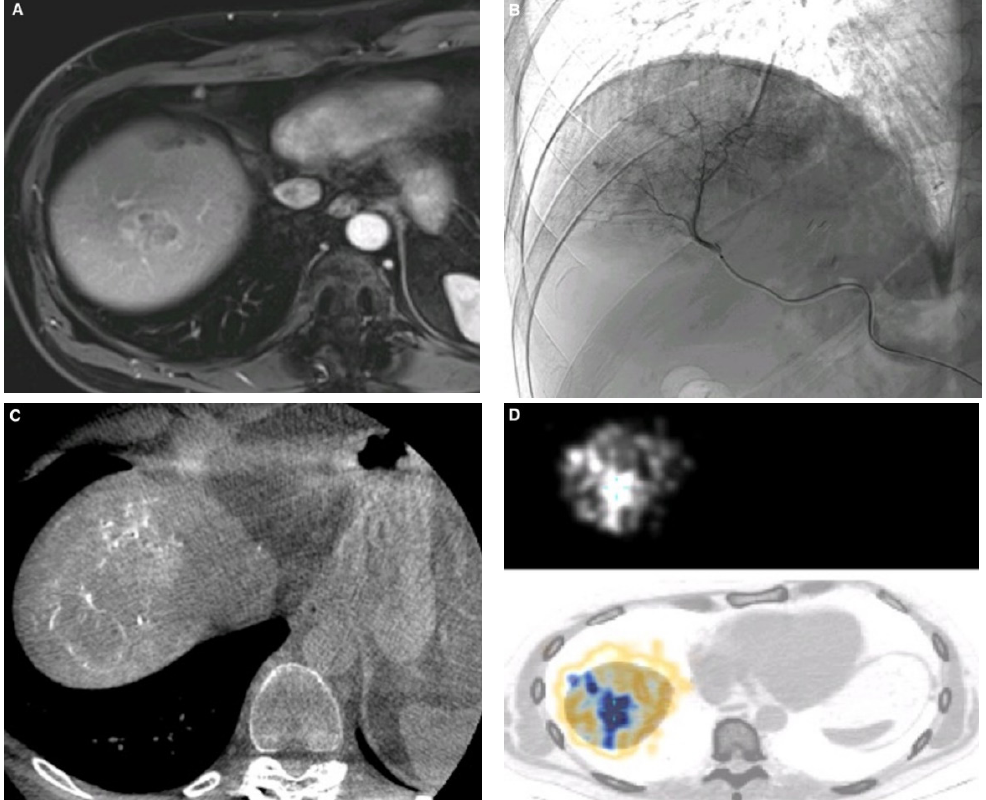
Figure 1. 51-year-old man with a single liver metastasis from colorectal cancer. ( A ) Hepatic magnetic resonance imaging (MRI) before Y90 transarterial radioembolization (TARE) showing contrast enhancement of the metastasis in the hepatic dome. ( B ) Selective angiography of arteries supplying the VII and VIII segments of the liver, obtained with a Progreat 2.4 microcatheter before the injection of Y90 microparticles. ( C ) Cone beam CT with contrast injection showing good targeted-lesion coverage with the microcatheter in the appropriate position. ( D ) Photon-emission tomography (PET) CT scan performed on the day following TARE, showing uptake by the targeted liver